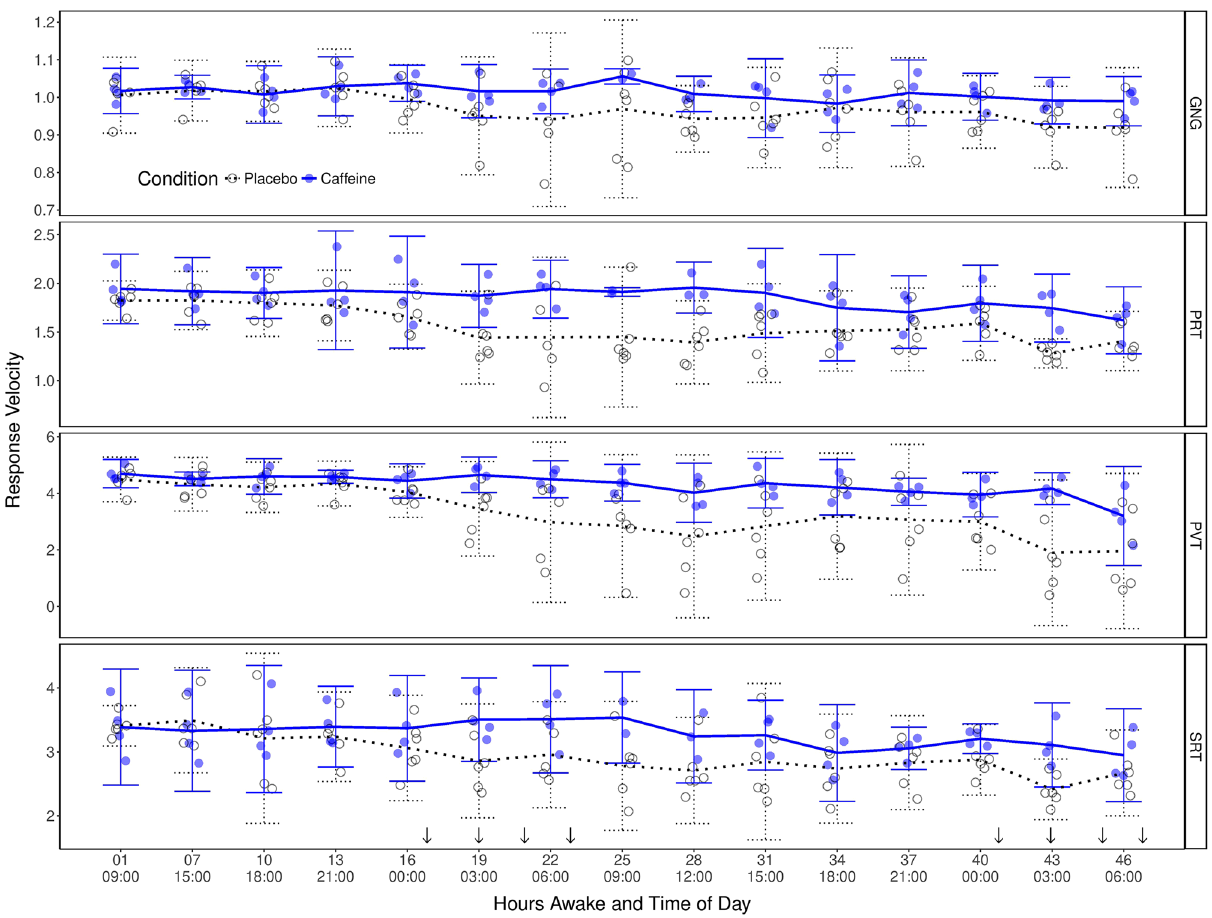
Figure 1. The time course of response speed (left y-axis) on vigilance (PVT and SRT panels denoted on the right), procedural decision making (PRT panel) and response inhibition tasks (GNG panel) for the caffeine (black filled circle, n = 4) and placebo (black open circle, n = 6) groups across our 50-h TSD protocol. Discrete values represent Response Velocities (per second) measured in PVT, SRT, PRT and GNG tasks following each simulated drive. The x-axes represent hours of continuous wakefulness (top) and time of day in a 24-h format (bottom). Arrows ( ↓ ) indicate the time of caffeine administration. Error bars represent 95% CIs.